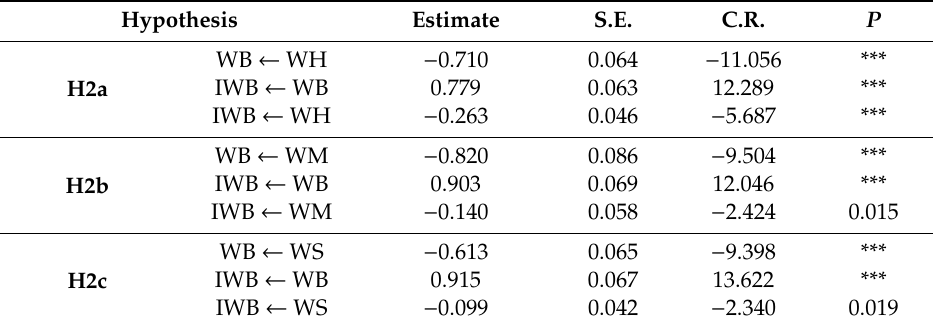
Table 5. Indirect E ff ects (path model